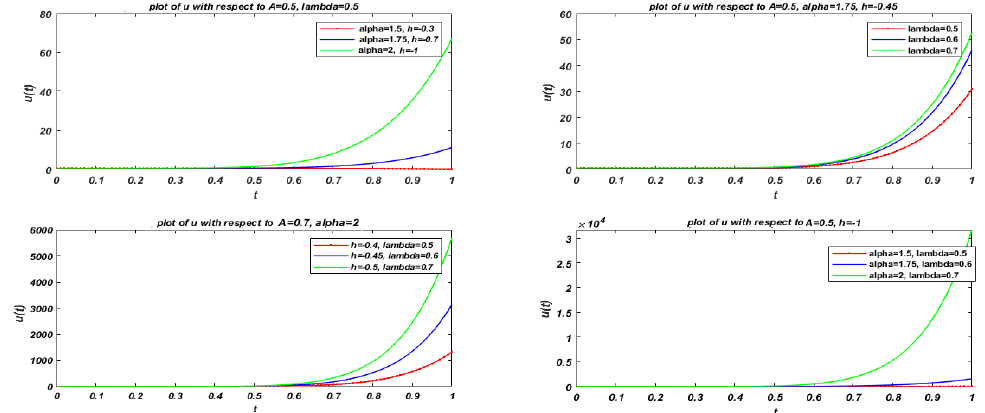
Figure 5. Plots of the OHAM’s solutions u ( t ) according to different values of A , δ , γ and α . plot of u according to A=0.1, h=−0.5, λ =0.5, α =1.8 plot of u according to A=1, h=−0.75, λ =0.95, α =1.75